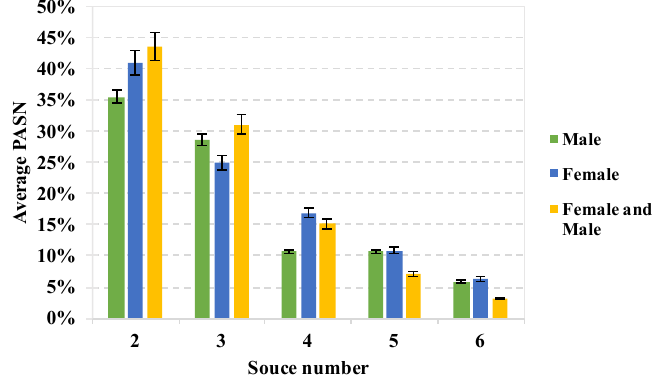
Figure 4. Average probability of active source number (PASN) among six simultaneously occurring